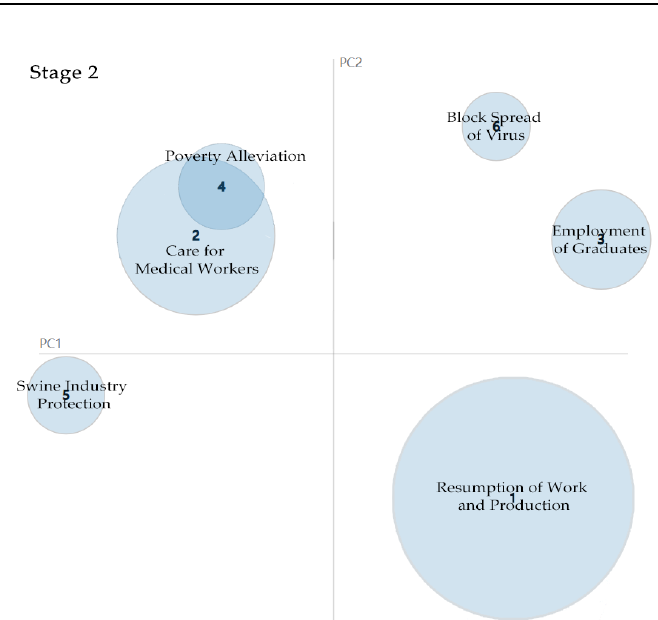
Figure 5. Topic intensity in Stage 2.